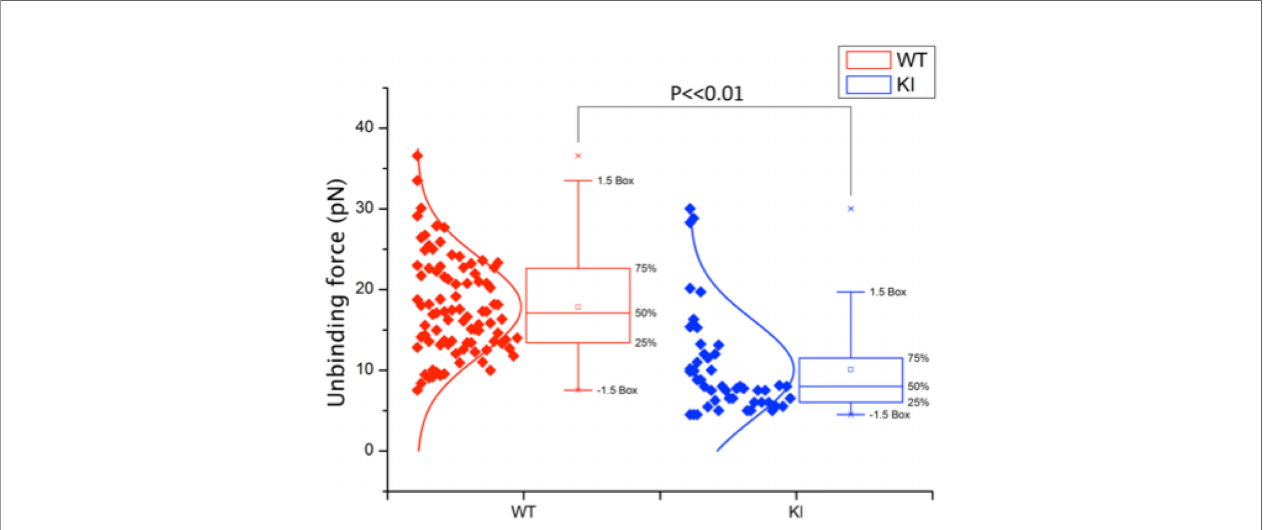
FIGURE 4 | Unbinding force of integrin – ligand pairs for both WT and KI cells, as measured by an optically trapped 2.56- m m bead, coated with 2 m g/ml ICAM-1, in contact with the cell for 1 s. WT unbinding force was measured as 17.85 ± 0.63 pN (N = 91), with KI unbinding force signi fi cantly lower at 10.08 ± 0.88 pN (N = 49) (mean ± std. error, p << 0.01) at an average force loading rate on the cell of 30.21 ± 4.35 pN/s.